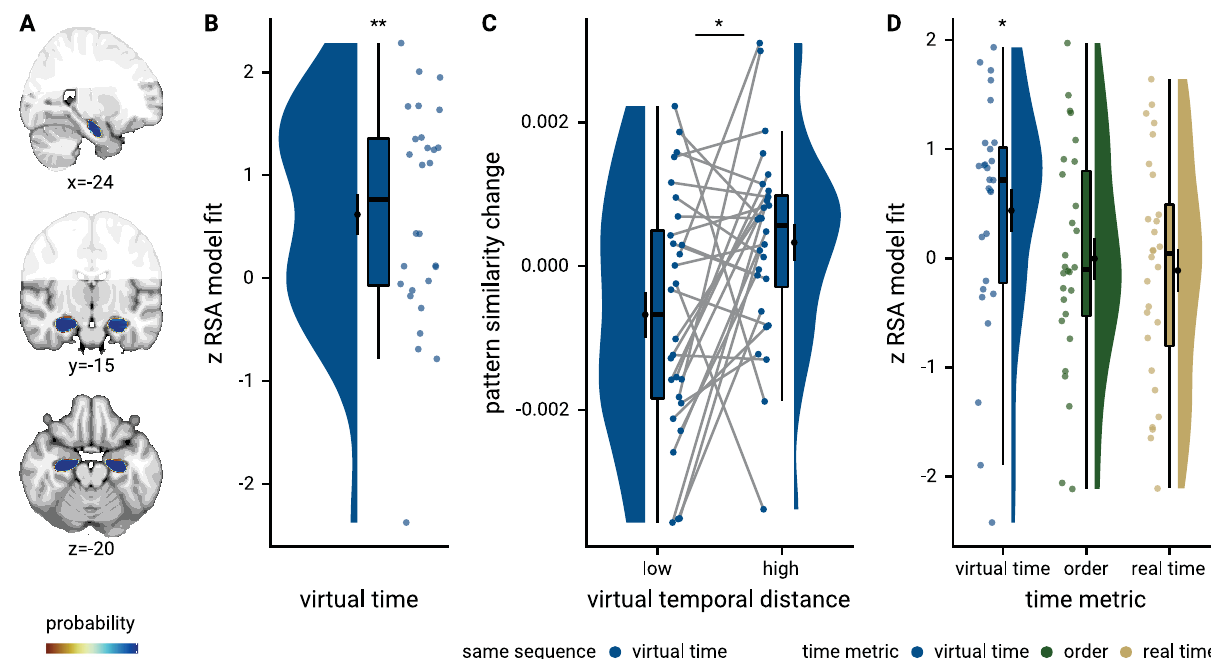
Fig. 4 Sequence representations in anterior hippocampus re fl ect constructed event times. A The anterior hippocampus region of interest is displayed on the MNI template with voxels outside the fi eld of view shown in lighter shades of gray. Color code denotes probability of a voxel to be included in the mask based on participant-speci fi c ROIs (see Methods). B The Z-values based on permutation tests of participant-speci fi c linear models assessing the effect of virtual time on pattern similarity change for event pairs from the same sequence were signi fi cantly positive. C To illustrate the effect shown in B , average pattern similarity change values are shown for same-sequence event pairs that are separated by low and high temporal distances based on a median split. D Z-values show the relationship of the different time metrics to representational change based on participant-speci fi c multiple regression analyses. Virtual time predicts pattern similarity change with event order and real time in the model as control predictors of no interest. B – D . Circles show data from n = 28 participants; boxplots show median and upper/lower quartile along with whiskers extending to most extreme data point within 1.5 interquartile ranges above/below the upper/lower quartile; black circle with error bars corresponds to mean ± S.E.M.; distributions show probability density function of data points. Source data are provided as a Source Data fi le. ** p < 0.01; * p <